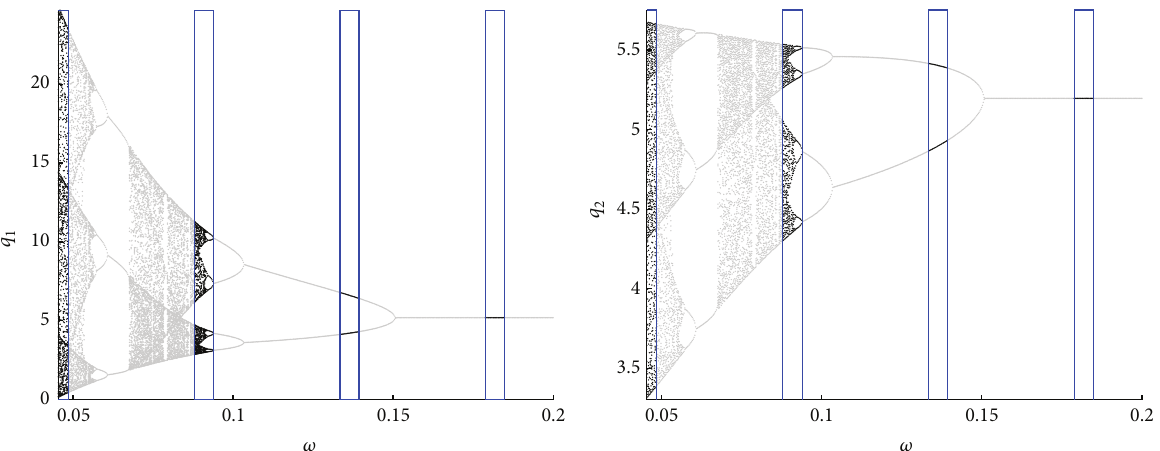
Figure 2: Bifurcation diagrams of quantities 𝑞 1 and 𝑞 2 with respect to the oligopoly composition 𝜔 , for 𝑁 = 22 , 𝑎 = 24 , 𝑏 = 0 . 2. Increasing the number of best response firms leads to instability.